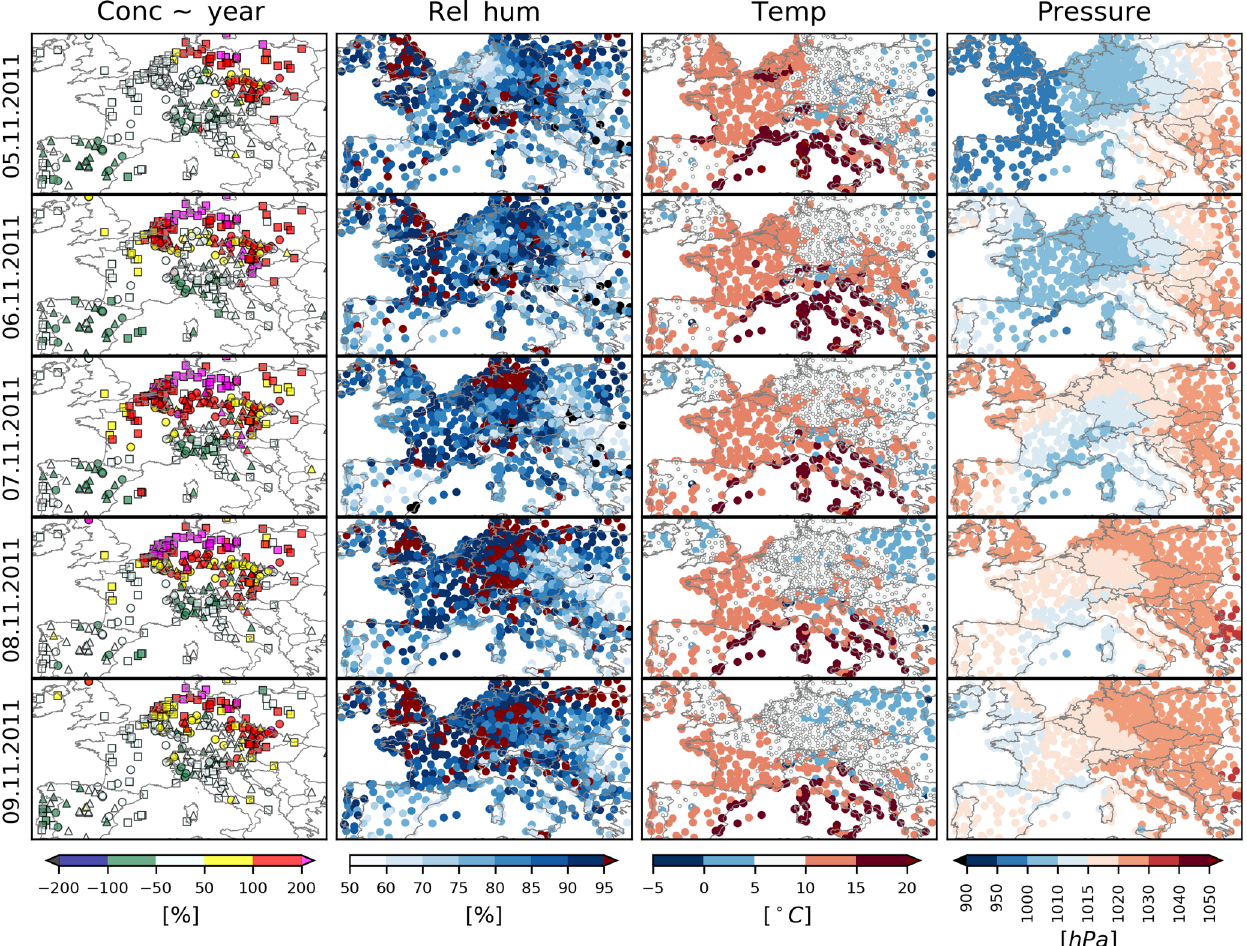
Figure 3. DF as “Conc ∼ year” and measurements from synoptic stations (relative humidity (Rel hum), ambient temperature at 2m (Temp) and surface pressure) from Ogimet (https://www.ogimet.com/, last access: 12 May 2020) during the first large-scale episode (5 to 9 Novem- ber). Stations with a temperature between 0 and 5 ◦ C are marked with little grey dots due to better representativeness on the